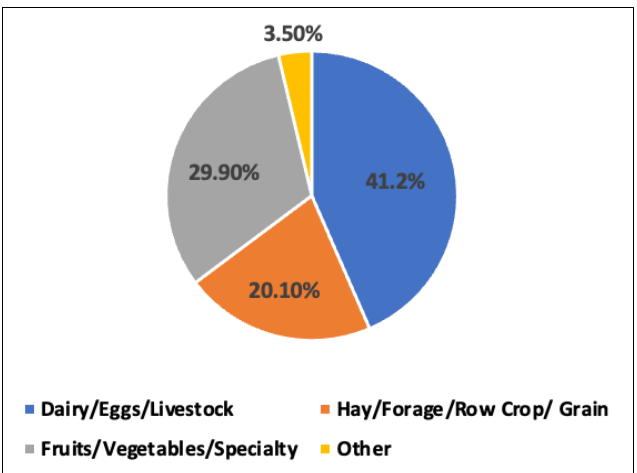
Figure 1. Predominant Farm Output of